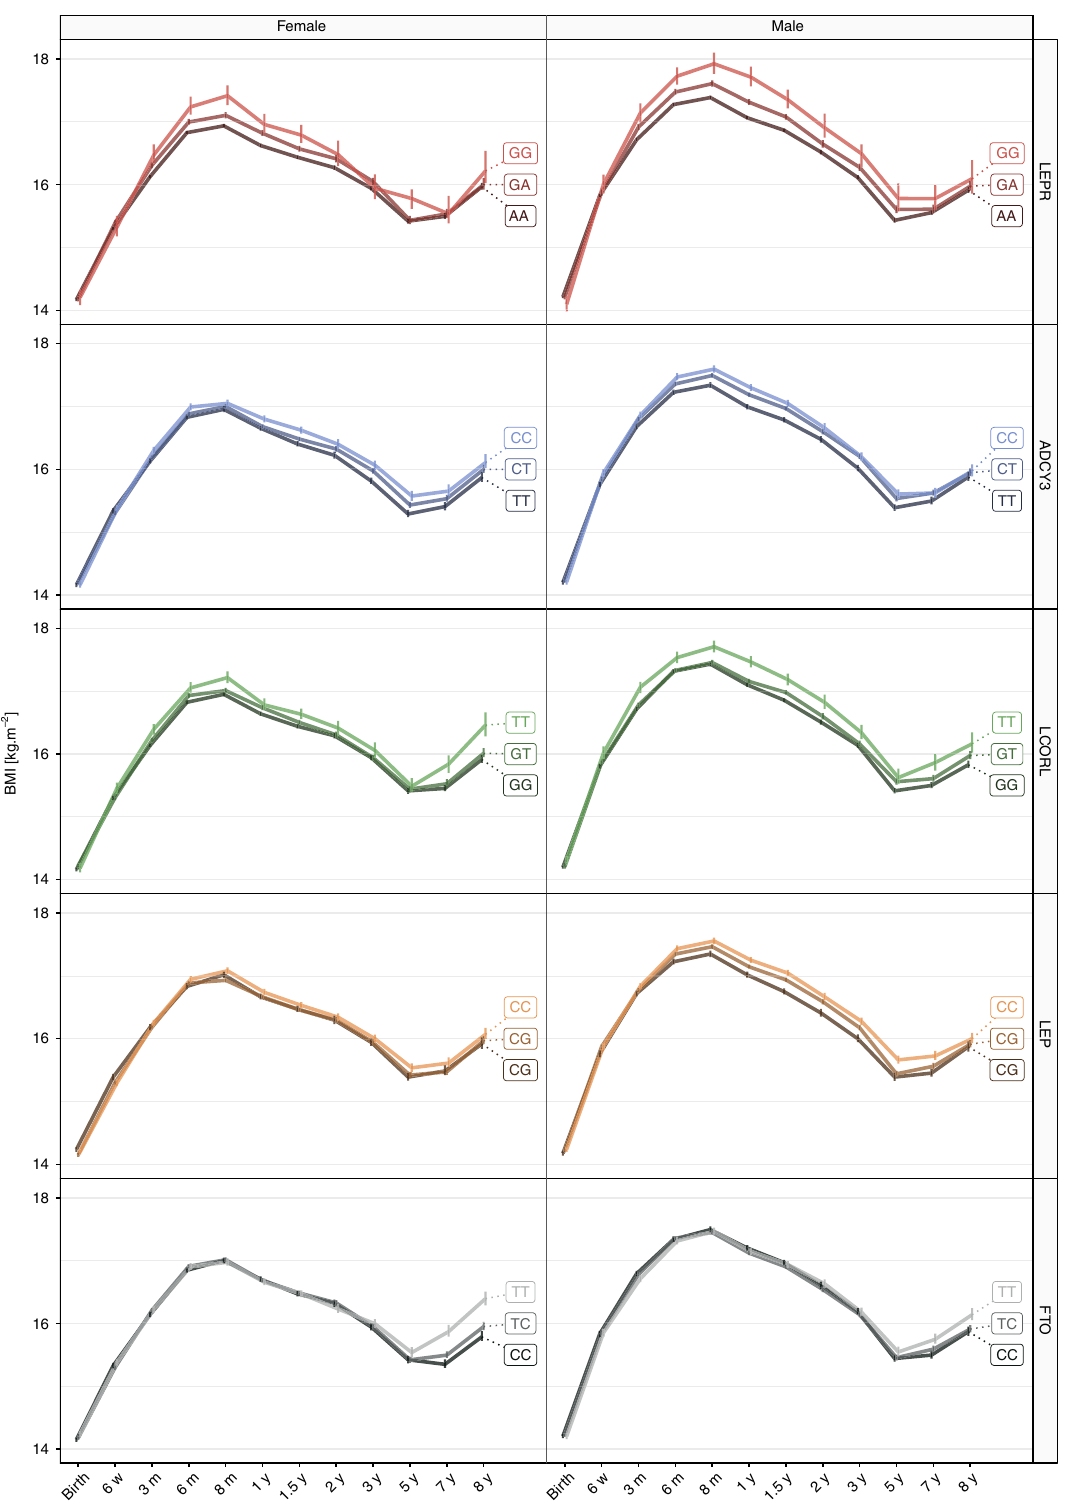
Fig. 4 BMI trajectories strati fi ed by lead SNPs in LEPR , ADCY3 , LCORL , LEP , and FTO . The median BMI in kg ⋅ m − 2 at each time point for all samples (discovery + replication) strati fi ed by genotypes in rs2767486 ( LEPR ), rs13035244 ( ADCY3 ), rs6842303 ( LCORL ), rs10487505 ( LEP ), and rs9922708 ( FTO ) in dark, intermediate, and light colors for females (left) and males (right). Error bars represent one standard error of mean (SEM) on each side of the